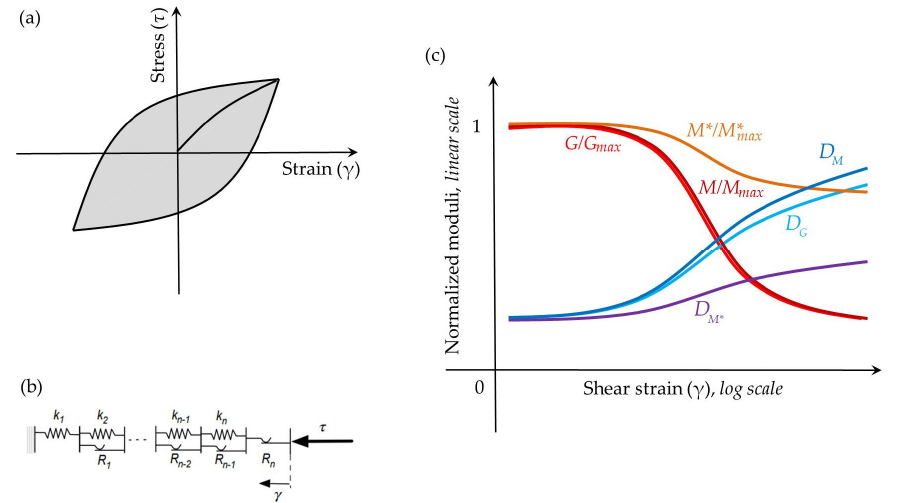
Figure 3. Hysteresis curve ( a ), schematic representation of stress-strain model introduced by [31,32] ( b ), degradation curves of shear modulus G/G max ( γ ) , constrained moduli above water table M/M max ( γ ) and under water table M*/M* max ( γ ) and corresponding damping ratio curves D G ( γ ), D M ( γ ), D M* ( γ ) ( c ). The right side of the governing equations of motion (14)–(16) can be written in terms of the tangential modulus: